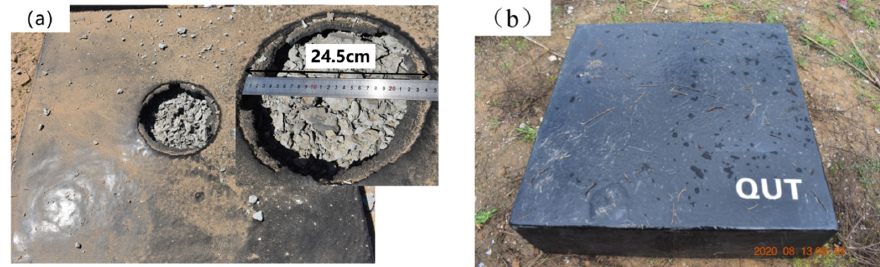
Figure 12. Failure modes of reinforced concrete slab coated with T26 after contact explosion: ( a ) blast face surface blast; ( b ) Face surface blastback blast surface.